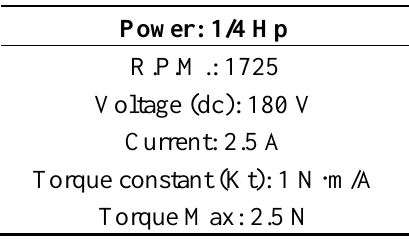
Table 2. Direct current motor